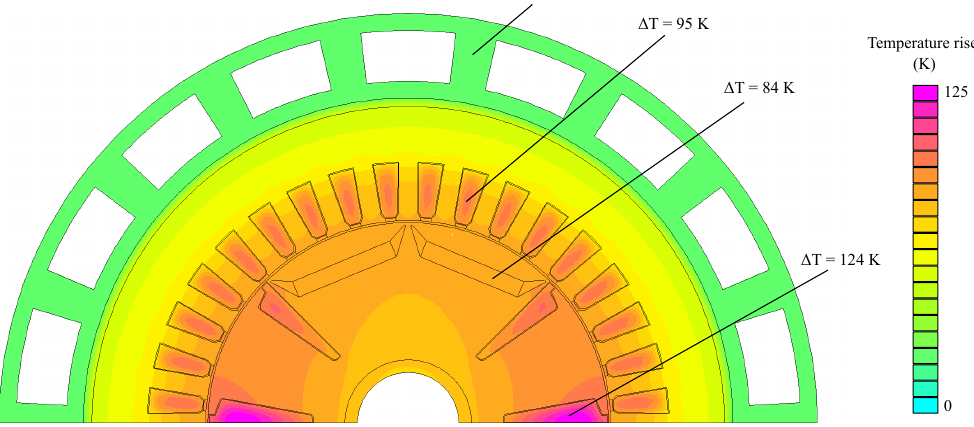
Figure 37. Temperature increase map for the HEPM motor with a water cooling system with oil flux along the